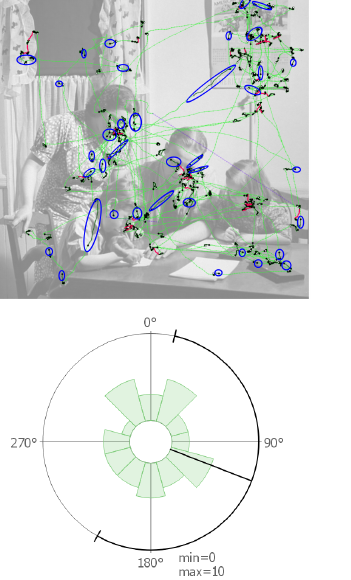
Figure 10. Usage of another fixation filter influences the sample ranges used for microsaccade detection and thus the rose plot visualizations. The left images use the fixations from the eye tracker, the right ones the fixations calculated by the application. Microsaccade detection was performed in both cases using the microsaccades filter with default parameter values. In the first row, some differences in the detected fixations are highlighted in blue. In the second row, it is visible that the microsaccade distribution for the trial changes as